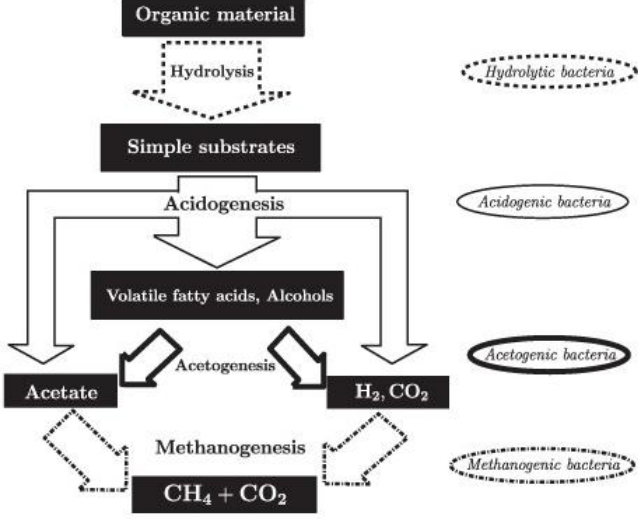
Figure 3. Schematic view of the various stages of anaerobic digestion processes. Source: [16].